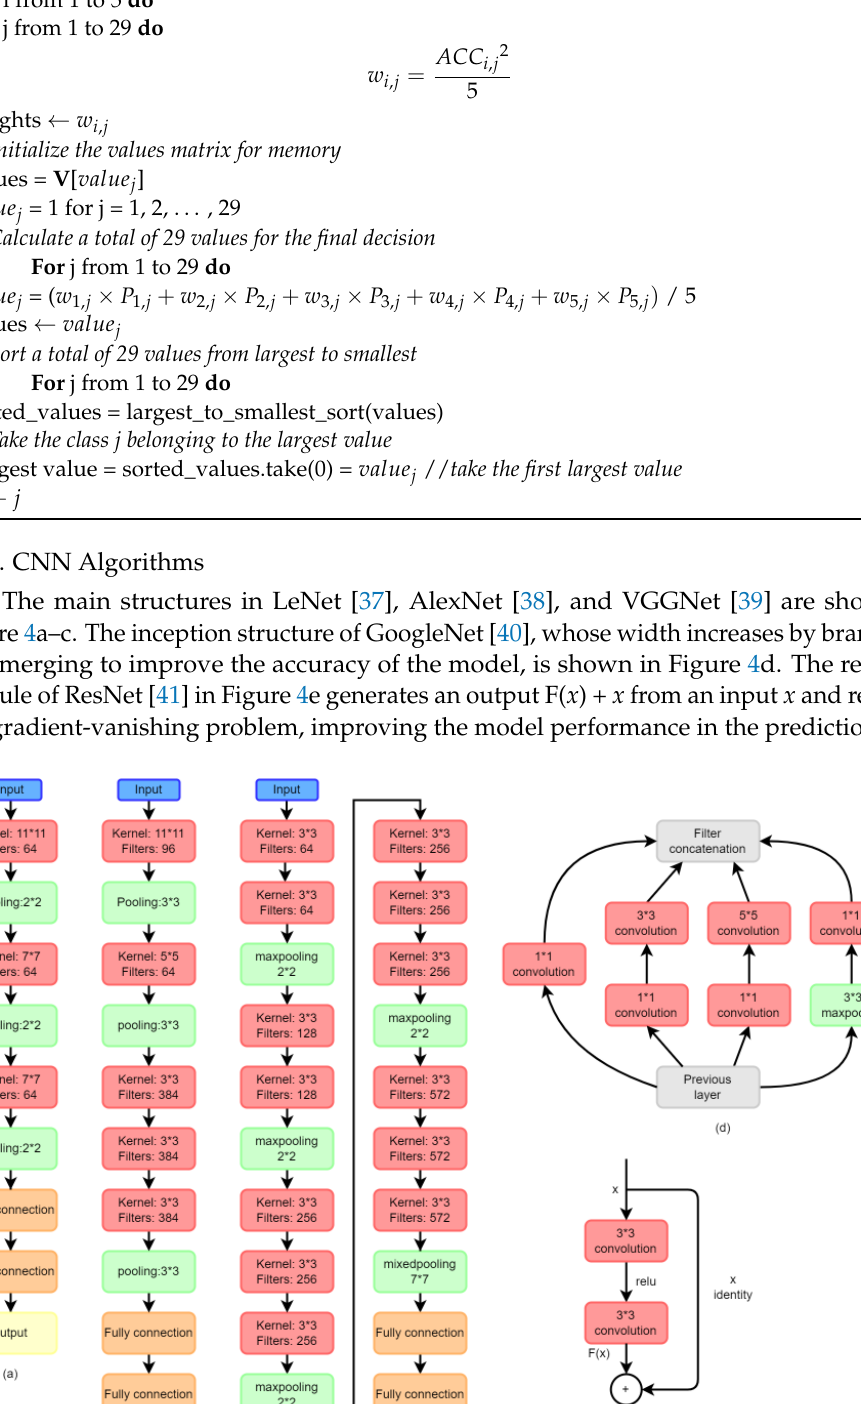
29 Table 2. The architecture of M-AlexNet. CNN Model